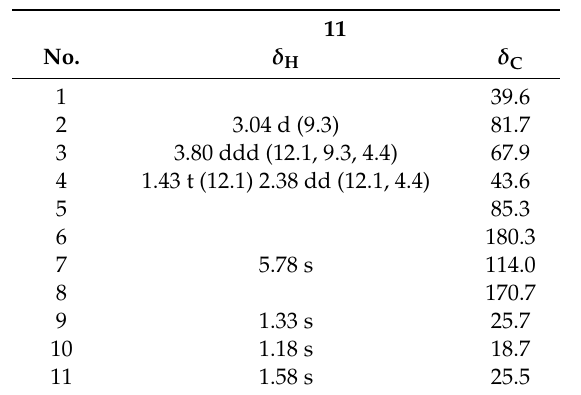
Table 2. 1 H- and 13 C-NMR spectral data of compound 11 ( δ in ppm, J in Hz) in acetone- d 6